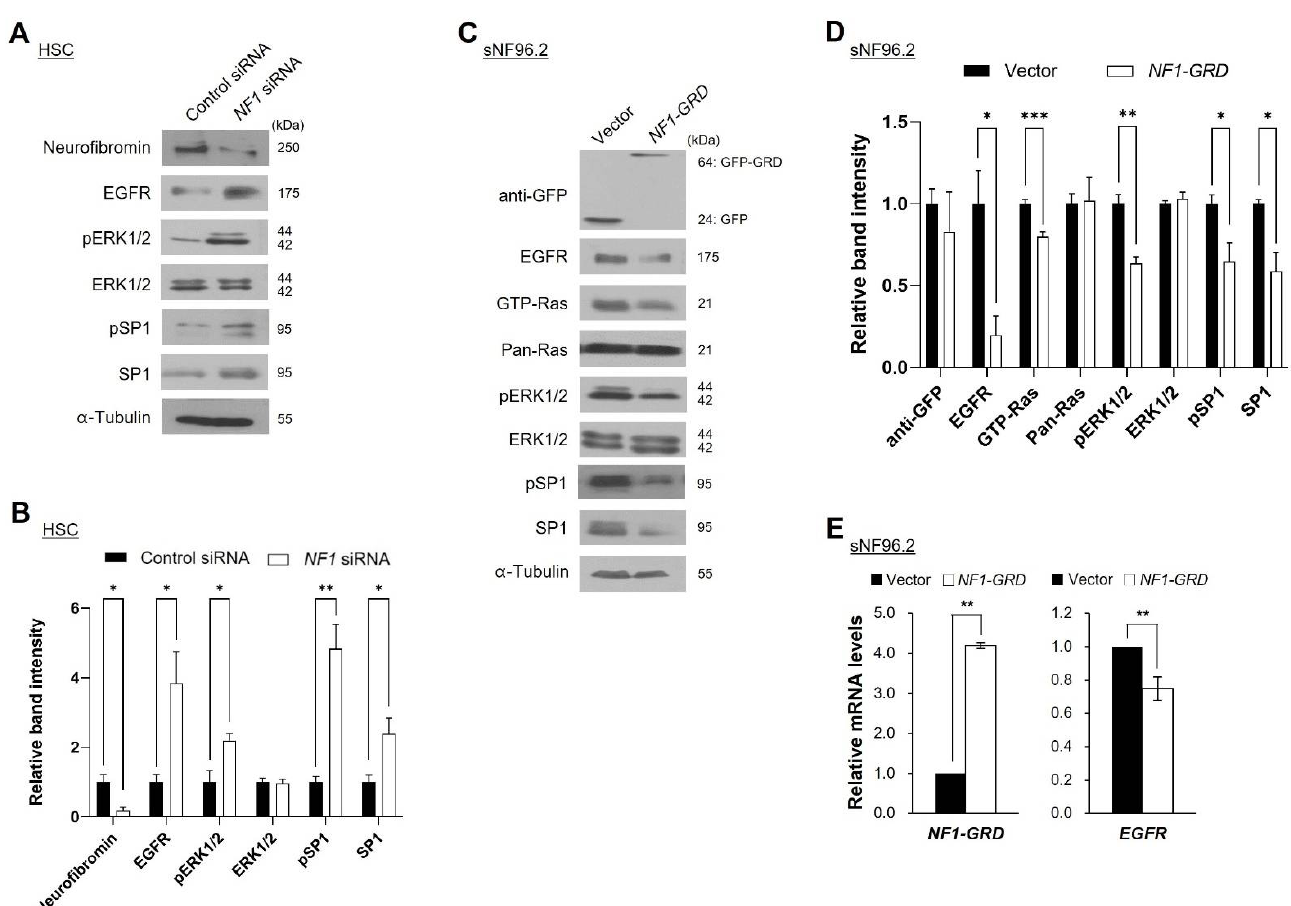
Figure 4. Changes in the EGFR, Ras, ERK1/2, and SP1 levels in the neurofibromin-depleted and neurofibromin-overexpressed cells. ( A ) Western blot analysis of the effect of NF1 siRNA and its downstream signaling pathways in HSCs. ( C ) sNF96.2 cells were transfected with an empty vector or GFP-tagged NF1-GRD . A total of 24 h after transfection, expression levels of the indicated proteins were determined by immunoblotting. ( B , D ) Immunoblot band density of specific proteins was normalized to the signal intensity of α-tubulin internal control for each sample. The western blot analysis was repeated at least three times with comparable results. Relative band intensity was quantified using ImageJ software. Two-tailed paired t -test was used for statistical analysis. *, p < 0.05, **, p < 0.01 and ***, p < 0.001. ( E ) The mRNA levels of EGFR or NF1-GRD were examined by quantitative RT-PCR. Two-tailed paired t -test was used for statistical analysis. **, p < 0.01.